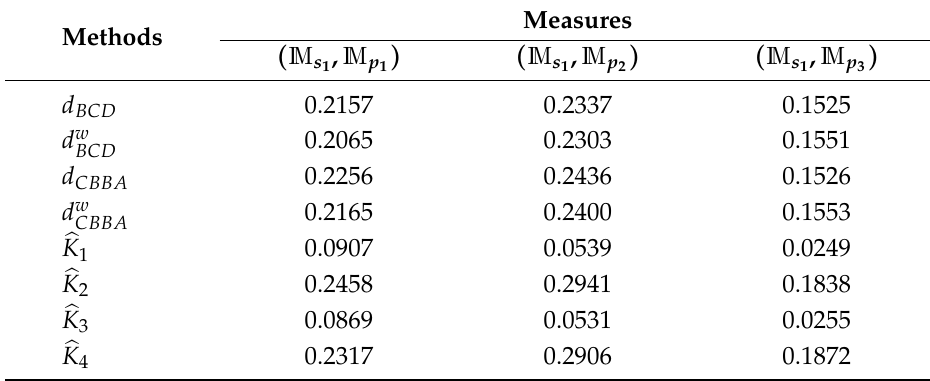
Figure 2. Comparison of different methods in the application. Table 5. The measures generated by different methods in the